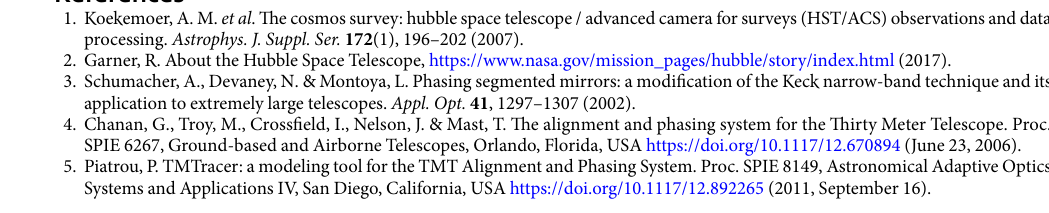
Table 3. Repeat test results of RMS and PV for the